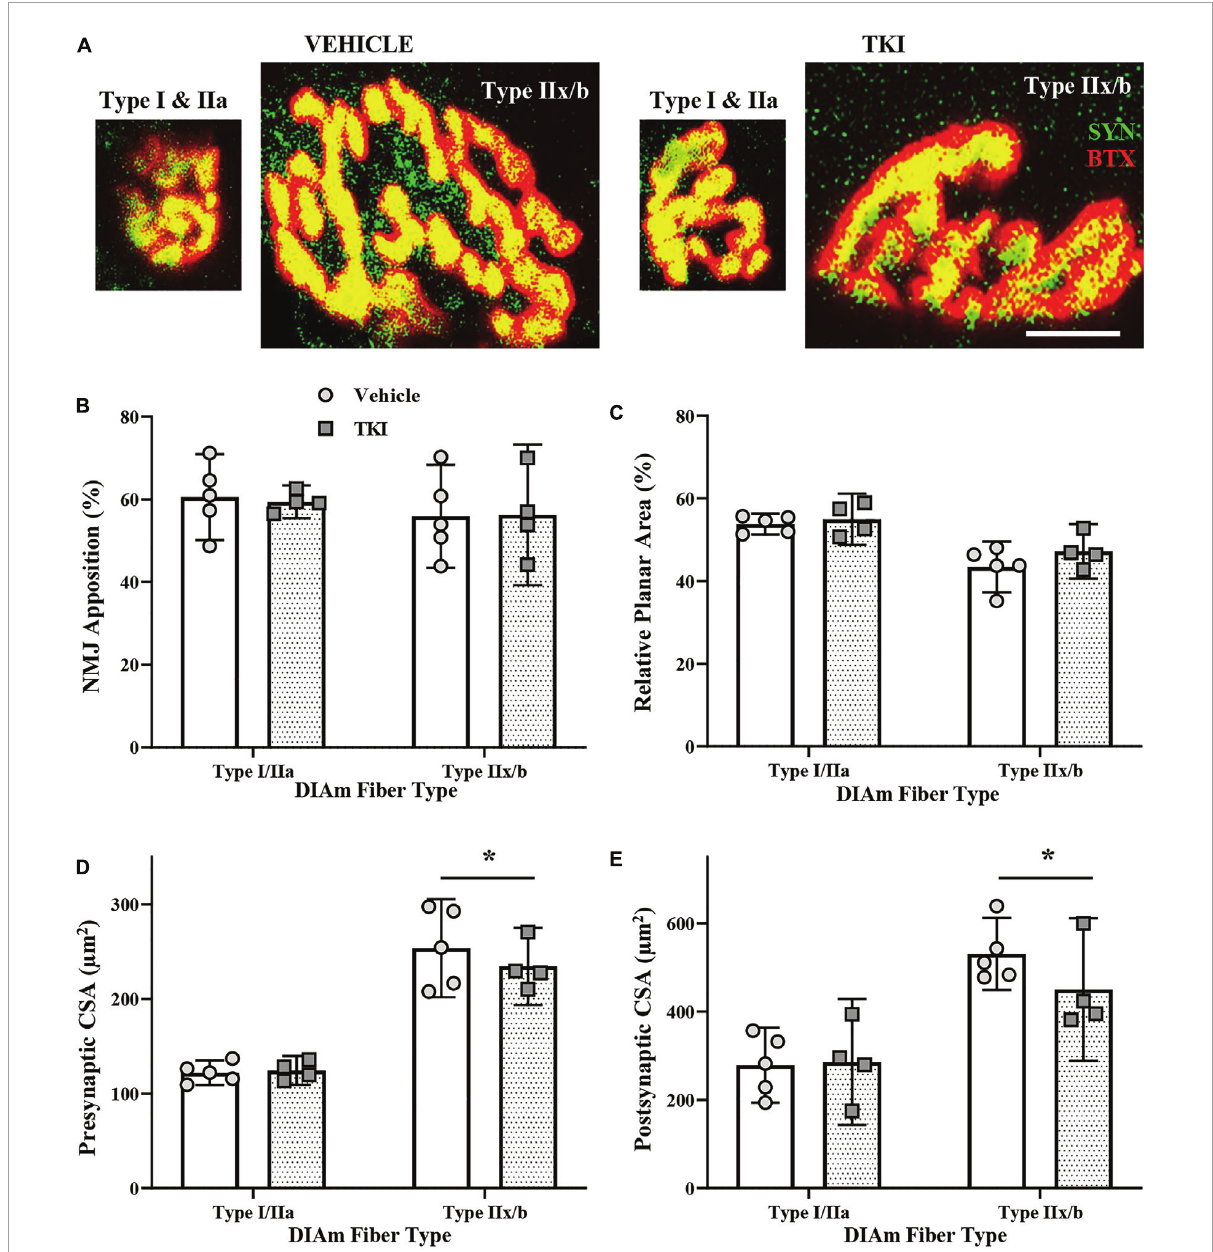
FIGURE6 Neuromuscular junction (NMJ) morphology is conserved in TrkB F 616 rats treated with 1NMPP1 for 14 days. (A) Pictomicrographs show NMJs labeled with pre-synaptic Synaptophysin (SYN-green) and post-synaptic α -Bungarotoxin (BTX-red) from type I or IIa fibers and type IIx and/or IIb DIAm fibers in vehicle control rats (left pair) and TKI rats (right pair) following 14 days of 1NMPP1 treatment. (B) Plot (mean ± 95% CI) shows mean NMJ pre- and post-synaptic apposition (%) is unchanged between vehicle and TKI rats. (C) Plot (mean ± 95% CI) shows mean NMJ relative planar area (%) is unchanged between vehicle and TKI rats. (D) Plot (mean ± 95% CI) shows mean NMJ pre-synaptic CSA ( µ m 2 ) is unchanged between vehicle and TKI rats, with CSA in type IIx and/or IIb fibers larger than type I or IIa fibers, regardless of treatment. (E) Plot (mean ± 95% CI) shows mean NMJ endplate CSA ( µ m 2 ) is unchanged between vehicle and TKI rats, with CSA in type IIx and/or IIb fibers larger than type I or IIa fibers, regardless of treatment. Two-Way ANOVAs with Bonferroni post-tests; n = 5 vehicle, n = 4 TKI rats. *Indicates difference between type I or IIa fibers and type IIx and/or IIb fibers, P < 0.05. Scalebar = 10 µ m.